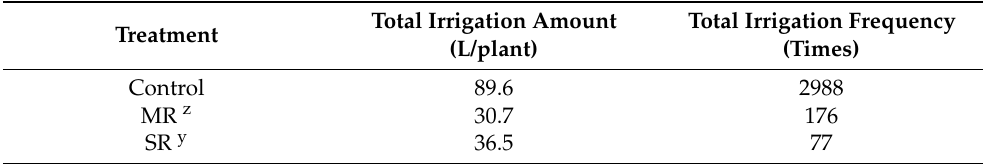
Table 1. Total irrigation amount and frequency during an 83-day treatment period. Total Irrigation Treatment